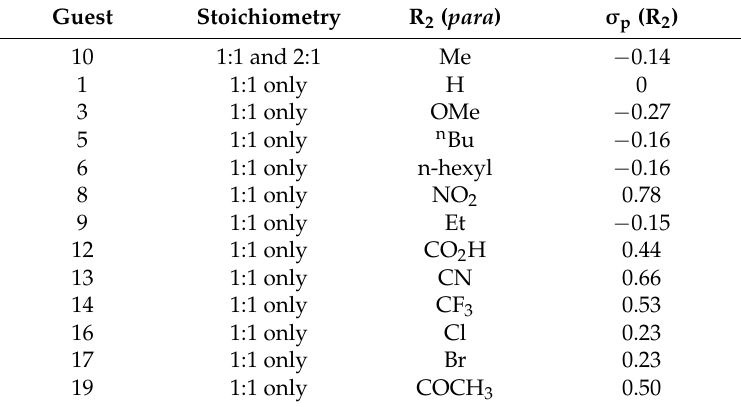
Table 6. Comparison of para -substituted 2-[(R-Phenyl)amine]-1,4-naphthalenediones which form 2:1 and 1:1 vs. only 1:1 complexes with γ